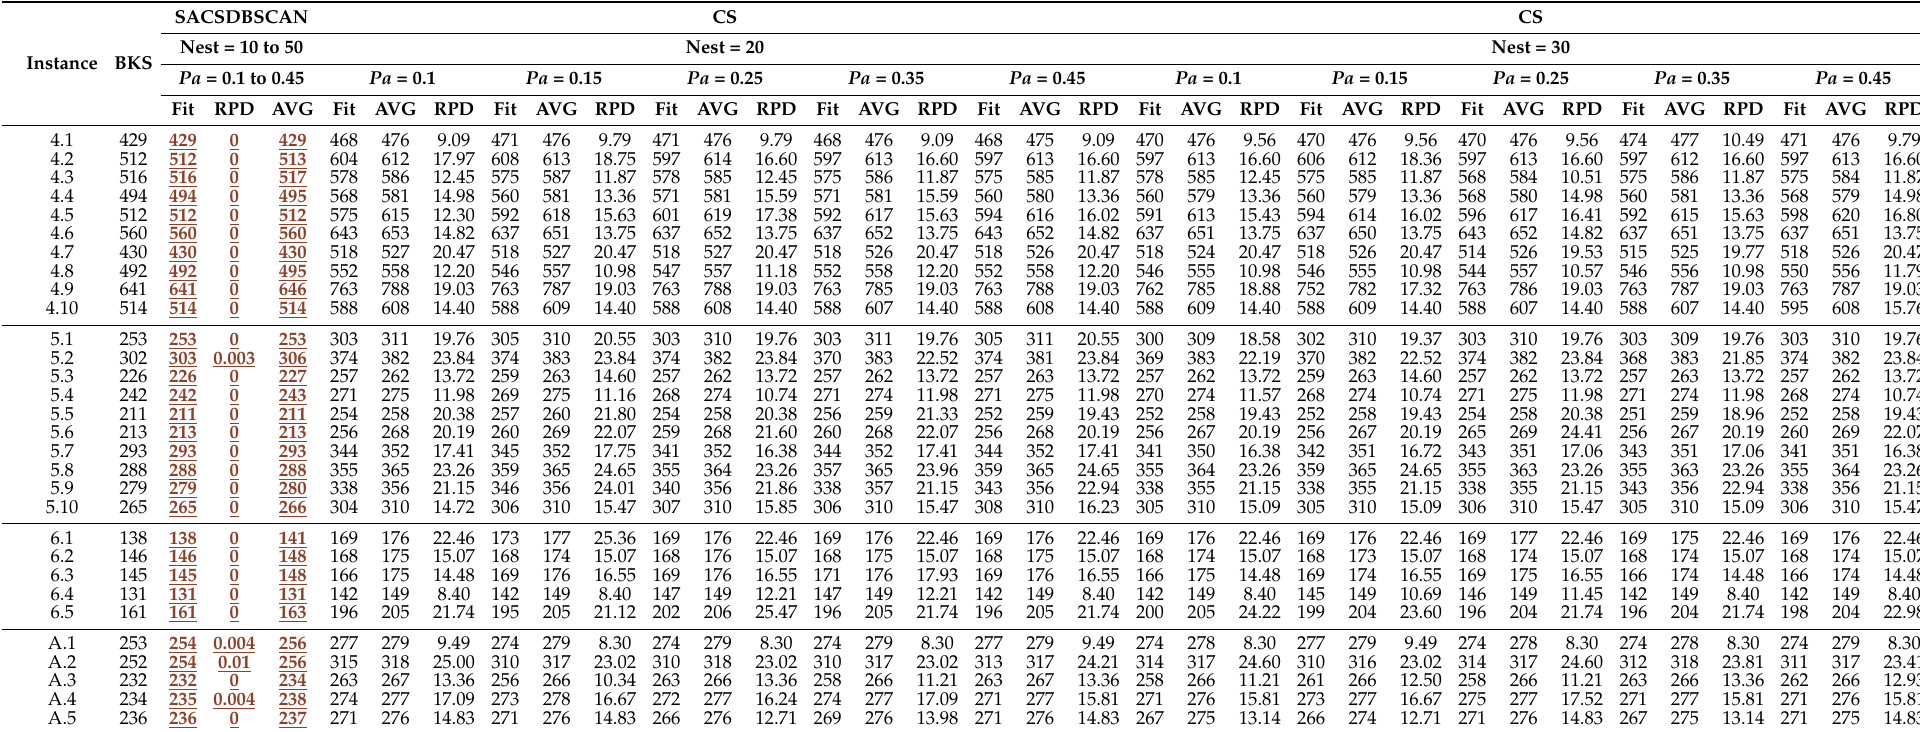
Table 5. Comparison results for set of groups 4, 5, 6, A. SACSDBSCAN v/s CS Nest = 20,